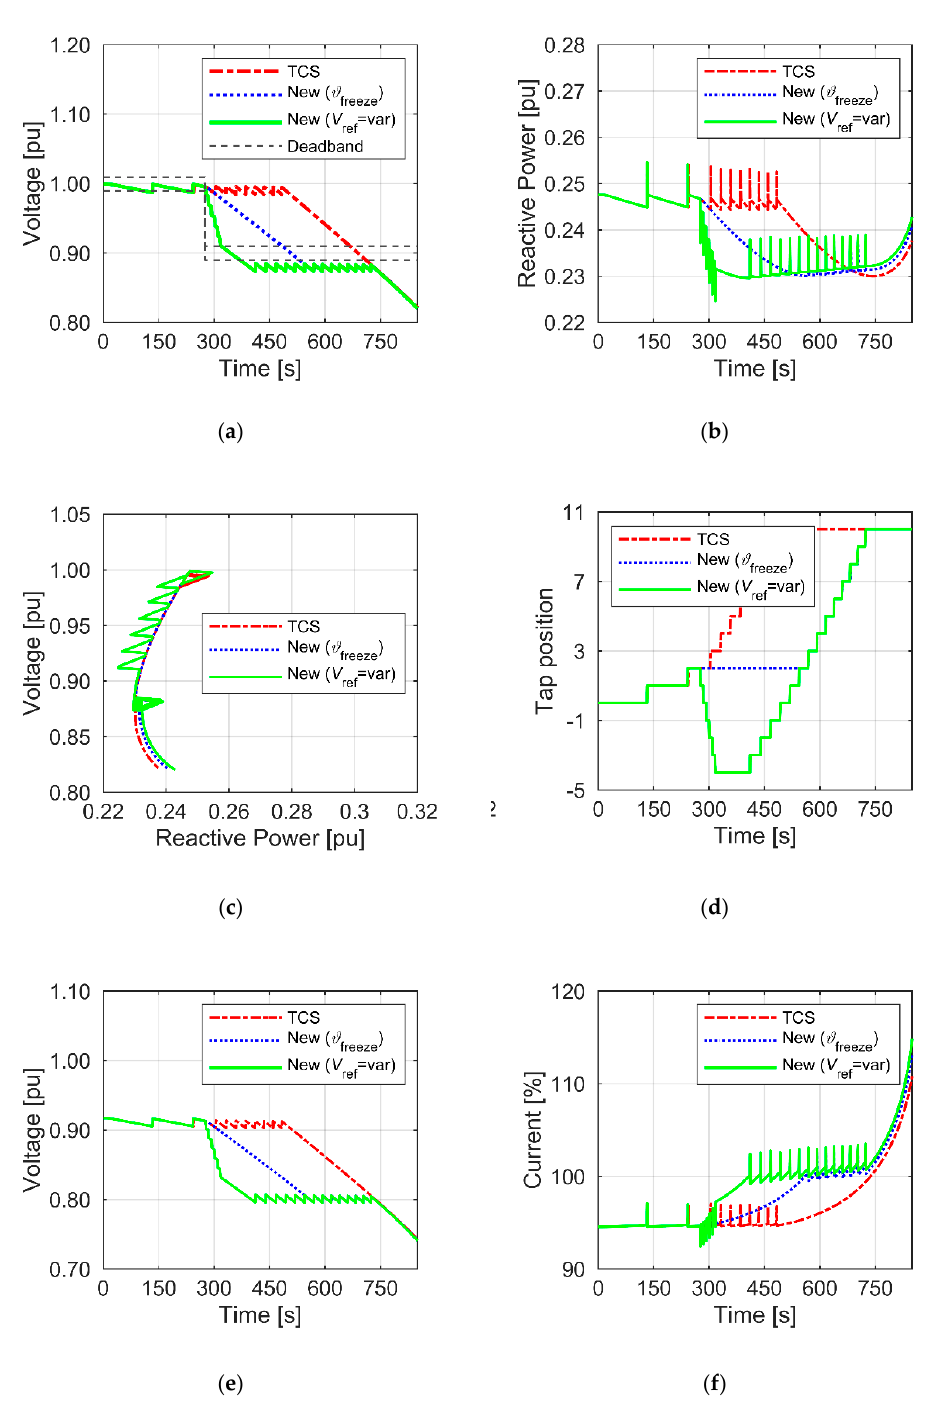
Figure 12. Verification of the effectiveness of the proposed algorithm (voltage drop on the HV side—2.5 kV/min): ( a ) voltage on MV bus of the HV/MV substation; ( b ) reactive power of the transformer; ( c ) characteristics V MV = f( Q MV ); ( d ) tap position; ( e ) voltage of loads; ( f ) I RMS of the asynchronous motor (expressed as a percentage of the rated current).